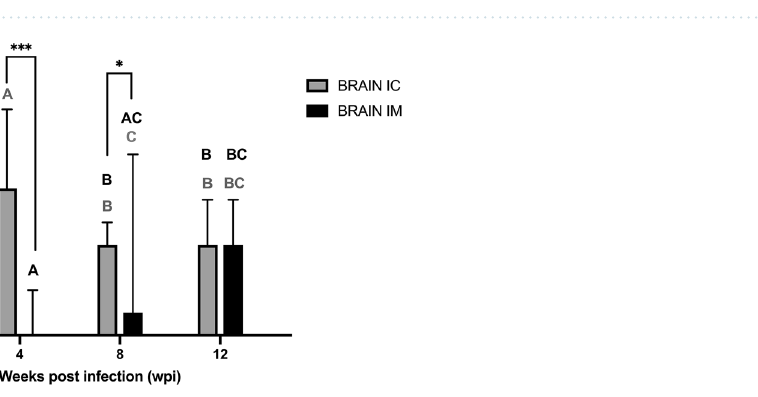
Figure 1. Graphs showing the pathology inflammation subscores in different areas of the brain of Muscovy ducks experimentally infected with ABBV-1 through the intracranial ( a ) or intramuscular ( b ) routes of infection, and assessed at 1, 4, 8, and 12 weeks post infection (wpi). Significant differences between terms within the same time point are identified with simple binary connectors. Flat lines at the end of a connector indicate differences with multiple underlying terms (significance level is reported for the highest p value among the comparisons). Significant differences of single organs at 4 wpi compared to organs at other time points are identified by different letters and color-coded (brain, red; optic lobe, blue; brainstem, green). Pairwise comparisons with data points scoring 0 (no inflammation) are not represented. Data columns represent median with data range. Krurskal-Wallis test with Benjamini, Krieger, and Yekutieli procedure for false discovery rate (* < 0.05, ** < 0.01, *** < 0.001).